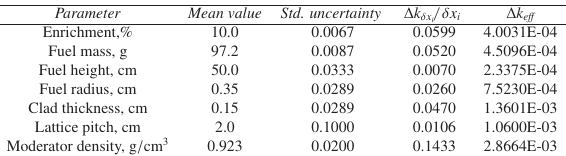
Table 2: Yalina-Thermal k e ff calculation uncertainties Parameter